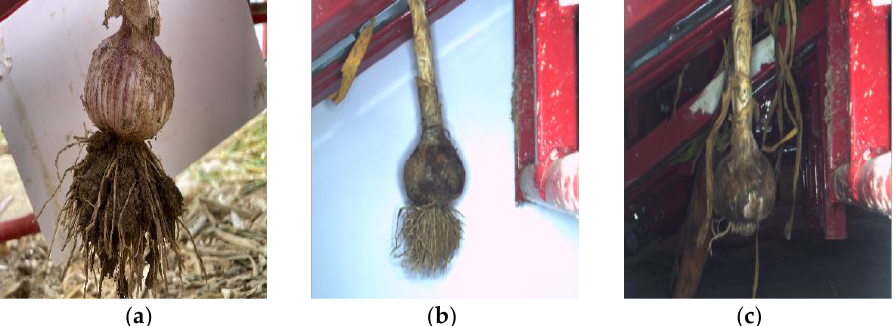
Figure 14. Some of the dataset images ( a ) Long garlic root; ( b ) Medium garlic root; ( c ) Short garlic root.